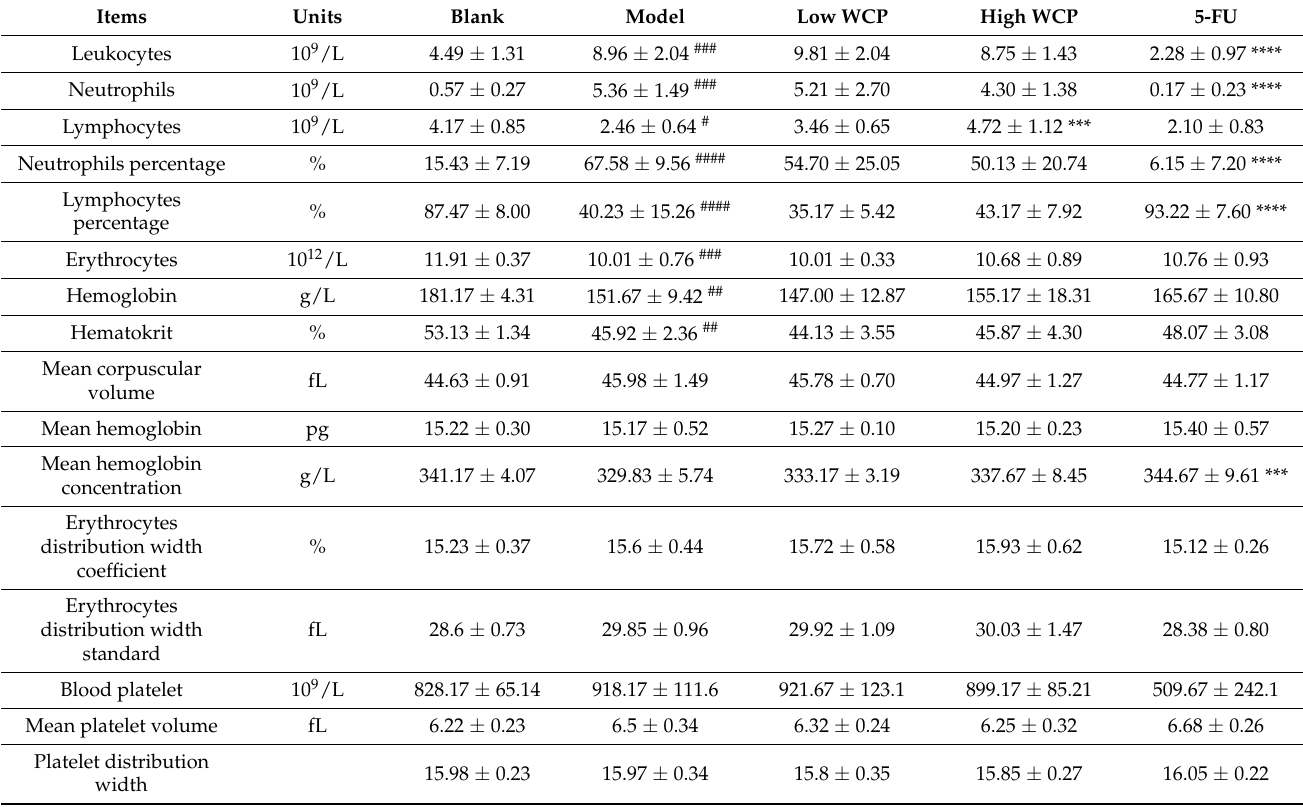
Table 1. The blood routine examination of H22 tumor-bearing